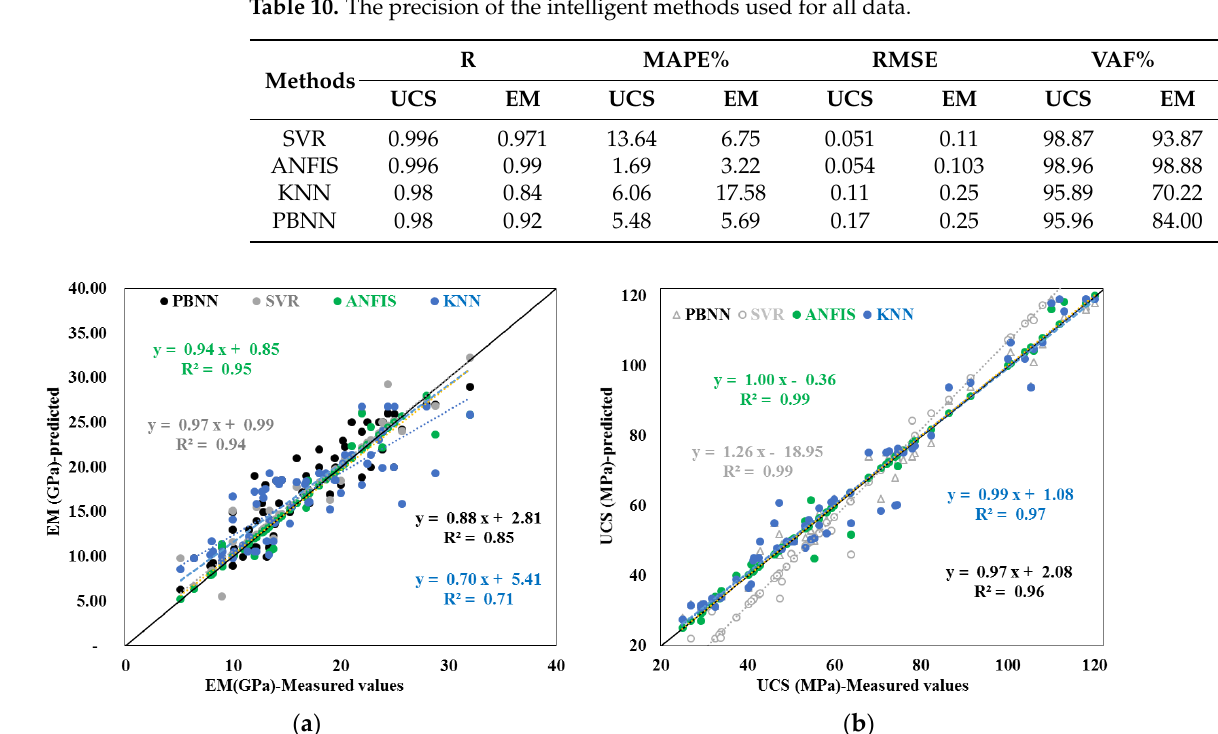
Figure 13. The precision of intelligent methods for forecasting static properties: ( a ) for EM and ( b ) for UCS.